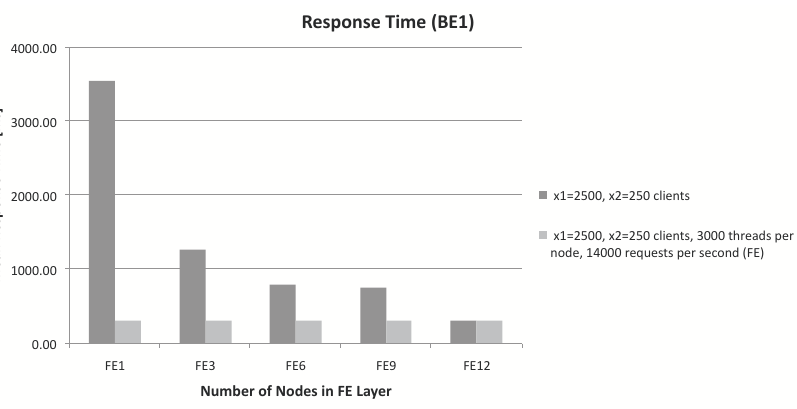
Figure 7. Response time for x 1 = 2500 clients (BE1), 3000 threads per node in FE